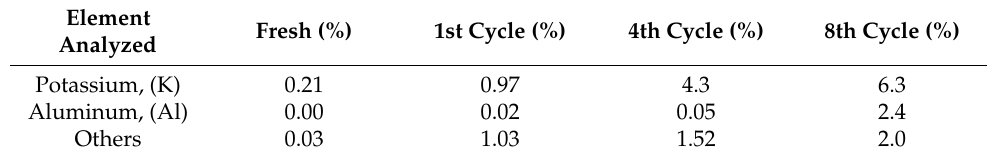
Table 3. XRF analysis results of used beads K 2 CO 3 /Al 2 O 3 catalyst in the transesterification